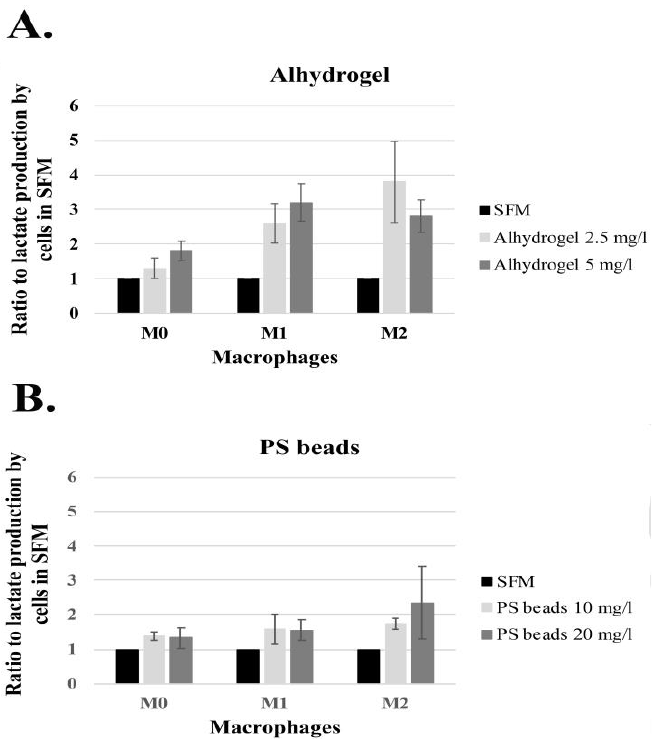
Figure 3. Normalized cellular lactate concentrations and standard error of the mean (SEM) from M0, M1, and M2 macrophages, average after incubation of Alhydrogel ® and macrophages independently differentiated and polarized from 9 donors ( A ), and respective PS beads from 6 donors, ( B ).